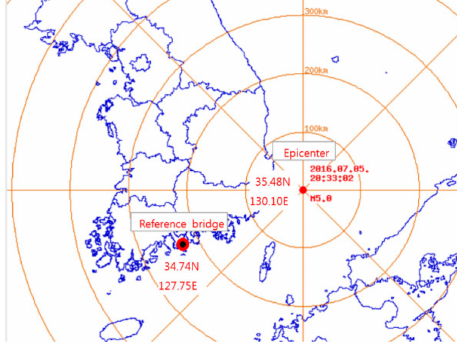
Figure 7. Location of the epicenter of the example